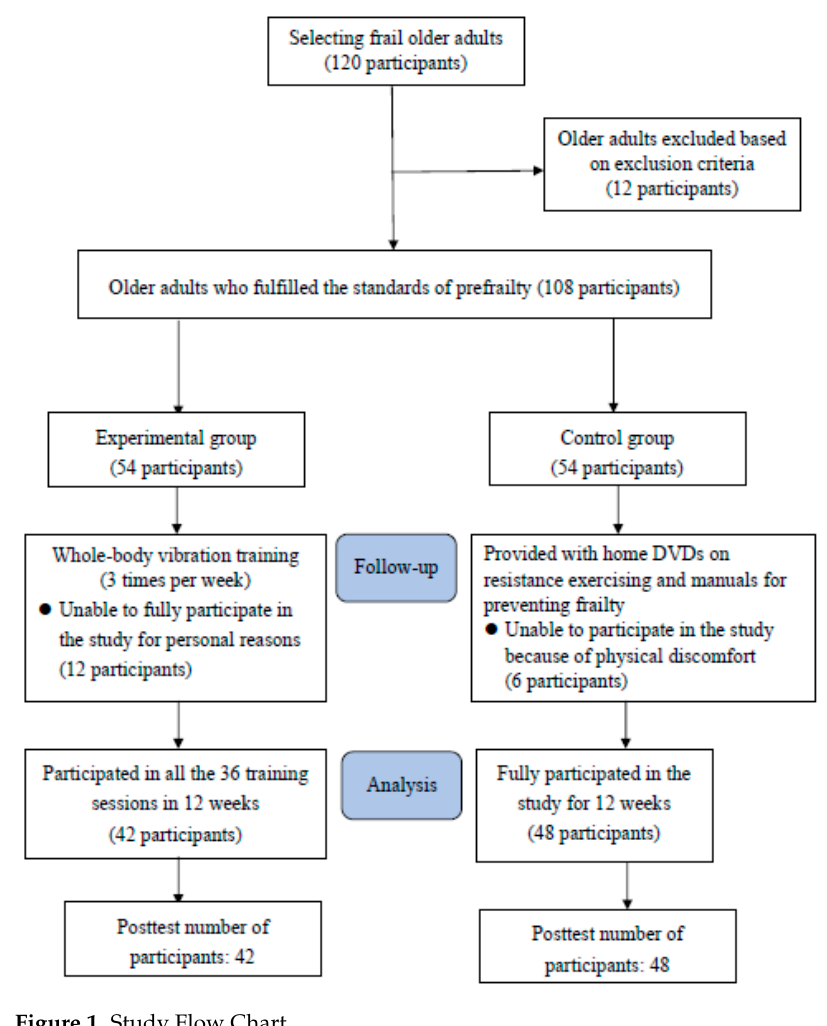
Figure 1. Study Flow Chart. Table 1. The homogeneity of the demographic characteristics between experimental and control groups in pre-test.